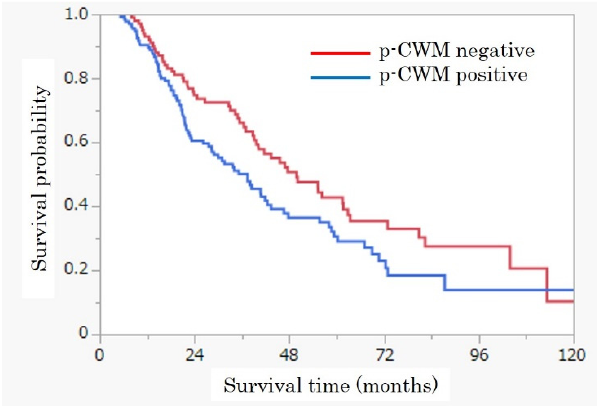
Figure 3. Survival curve according to p-CWM, which showed that the patients with p-CWM had a significant shorter survival time than without p-CWM.